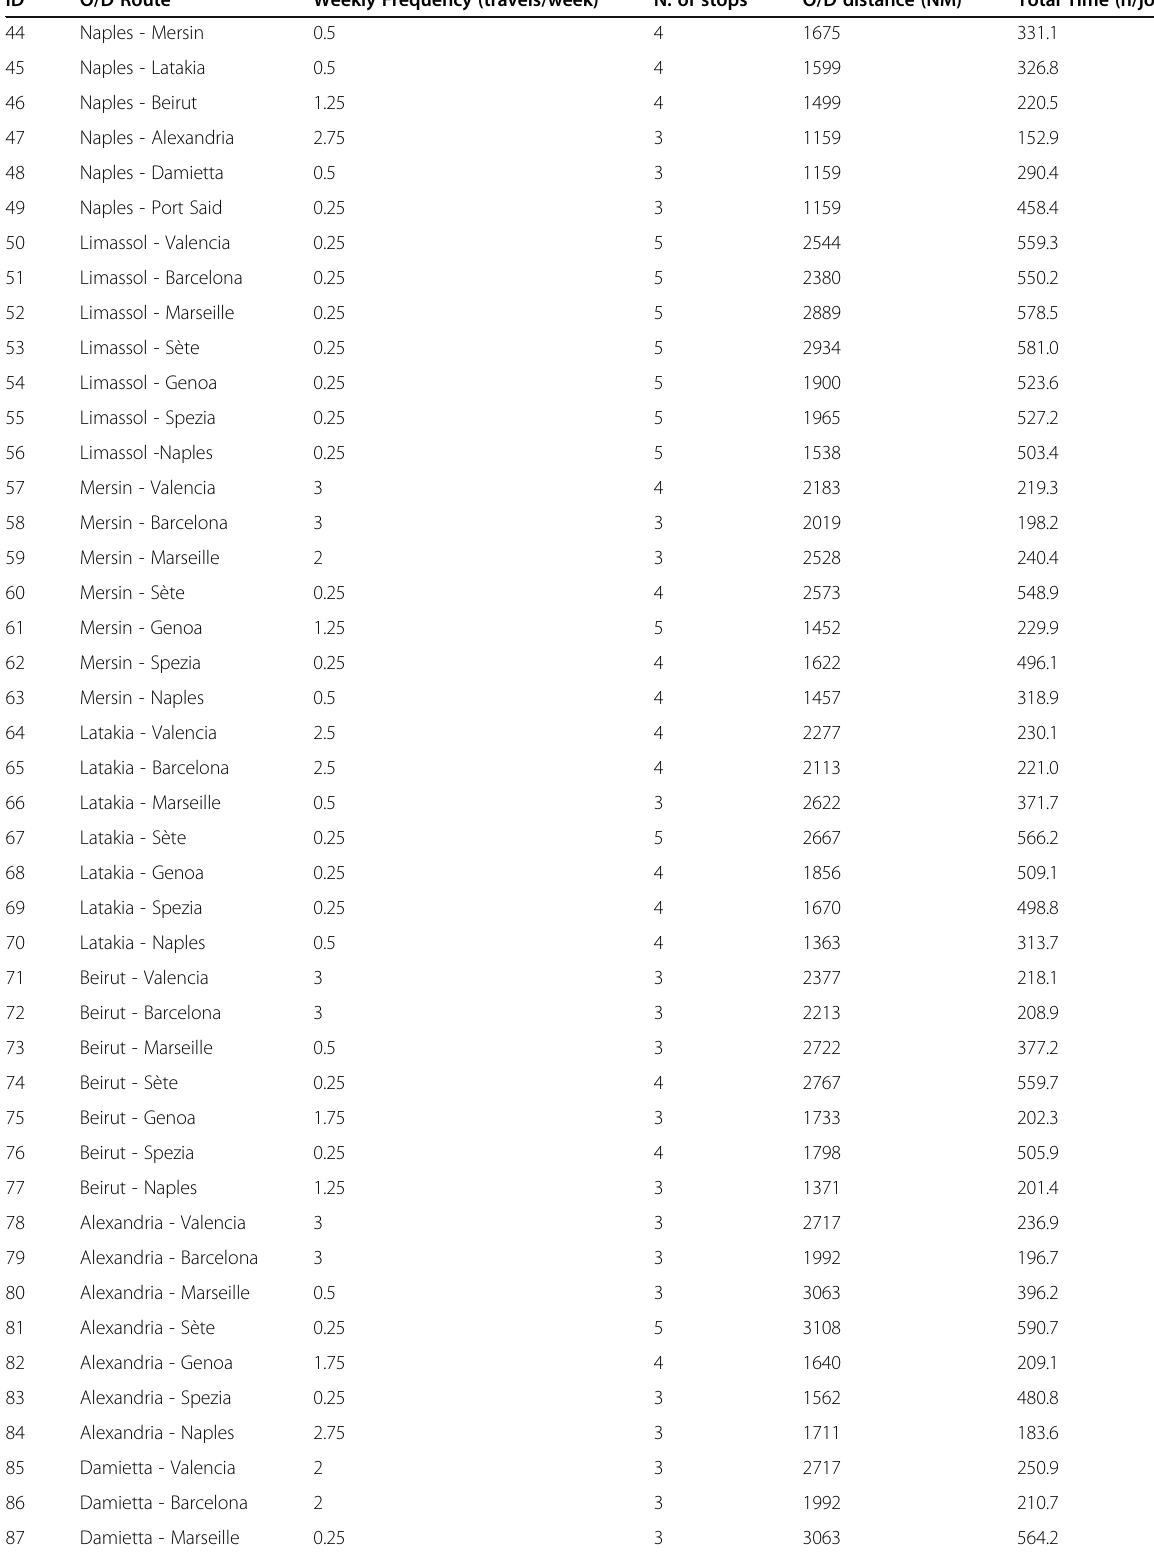
Table 19 General features of the existing network